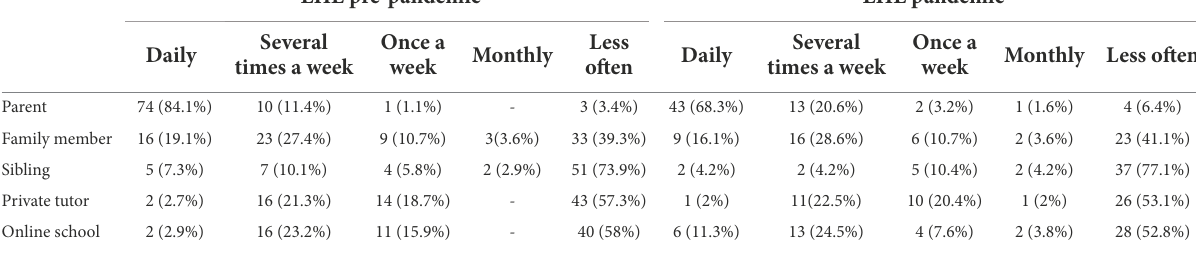
TABLE 4 Type of equipment needed for child’s home learning presented for the two EHE groups. EHE pre-pandemic EHE pandemic Had access but Needed and had Needed but did Needed and had Needed but did need more or access to not have access access to not have access better quality